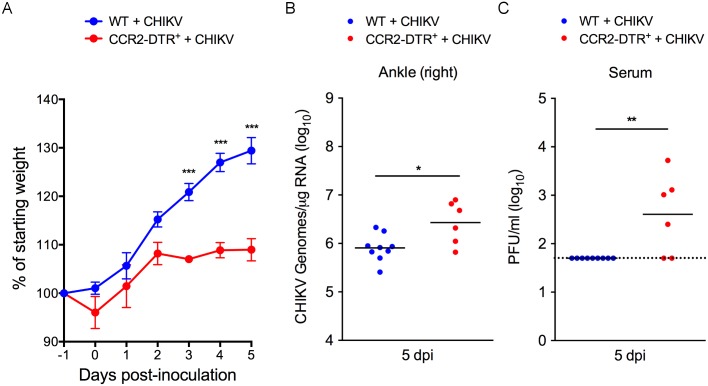
Depletion of CCR2+ cells enhanced viral loads in tissues and the severity of disease during acute CHIKV infection.WT (n = 9) or CCR2-DTR (n = 6) C57BL/6 mice were inoculated in the left rear footpad with 1,000 PFU of CHIKV. At days -1 and +2 relative to infection, mice were i.p. administered DT. (A) The percent starting body was determined daily. At 5 dpi, (B) viral RNA levels in the contralateral ankle were quantified by qRT-PCR and (C) infectious virus in the serum was quantified by plaque assay. Data are pooled from three independent experiments. P values were determined by a repeated measures two-way ANOVA with a Bonferroni’s multiple comparison test (A) and by Student’s t-test (B, C). *, P <0.05; **, P < 0.01; ***, P < 0.001.